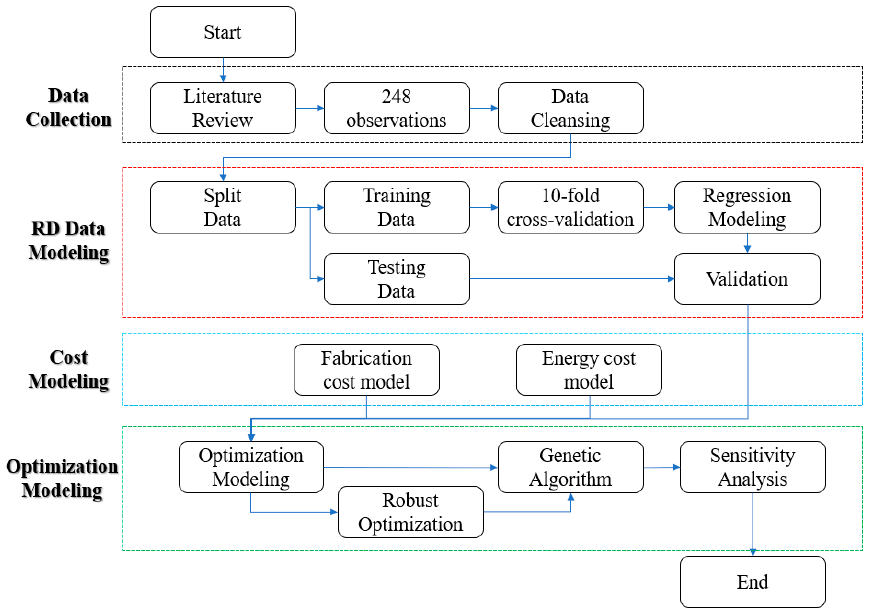
Figure 1. Schematic diagram of the process of the methods used in this study. Table 1. Studies from the literature used for data collection.